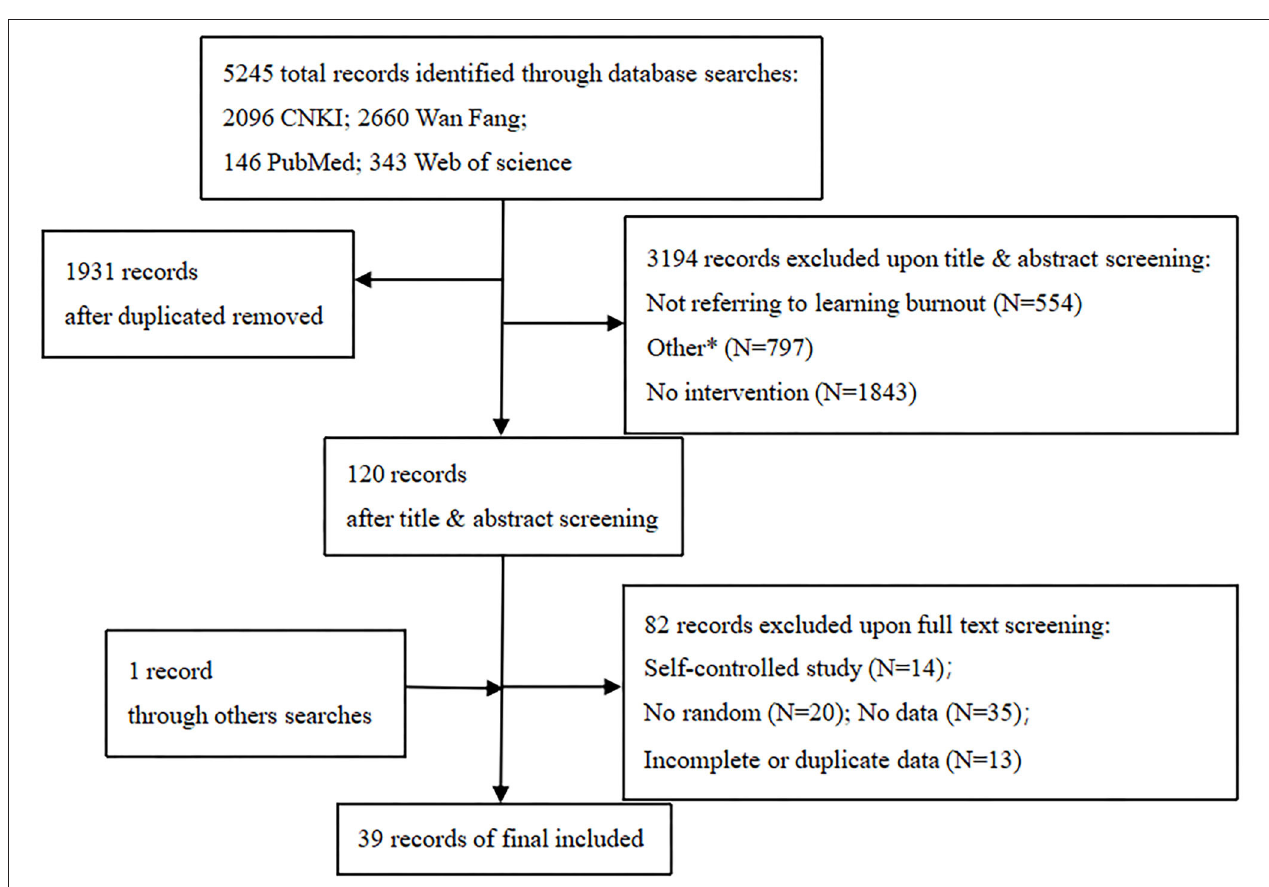
FIGURE 1 | Flow Chart of Study Selection. Flow chart shows literature search for relevant studies about interventions on learning burnout. *Studies were excluded because they were either news reports, commentaries, editorials or a review, protocol.